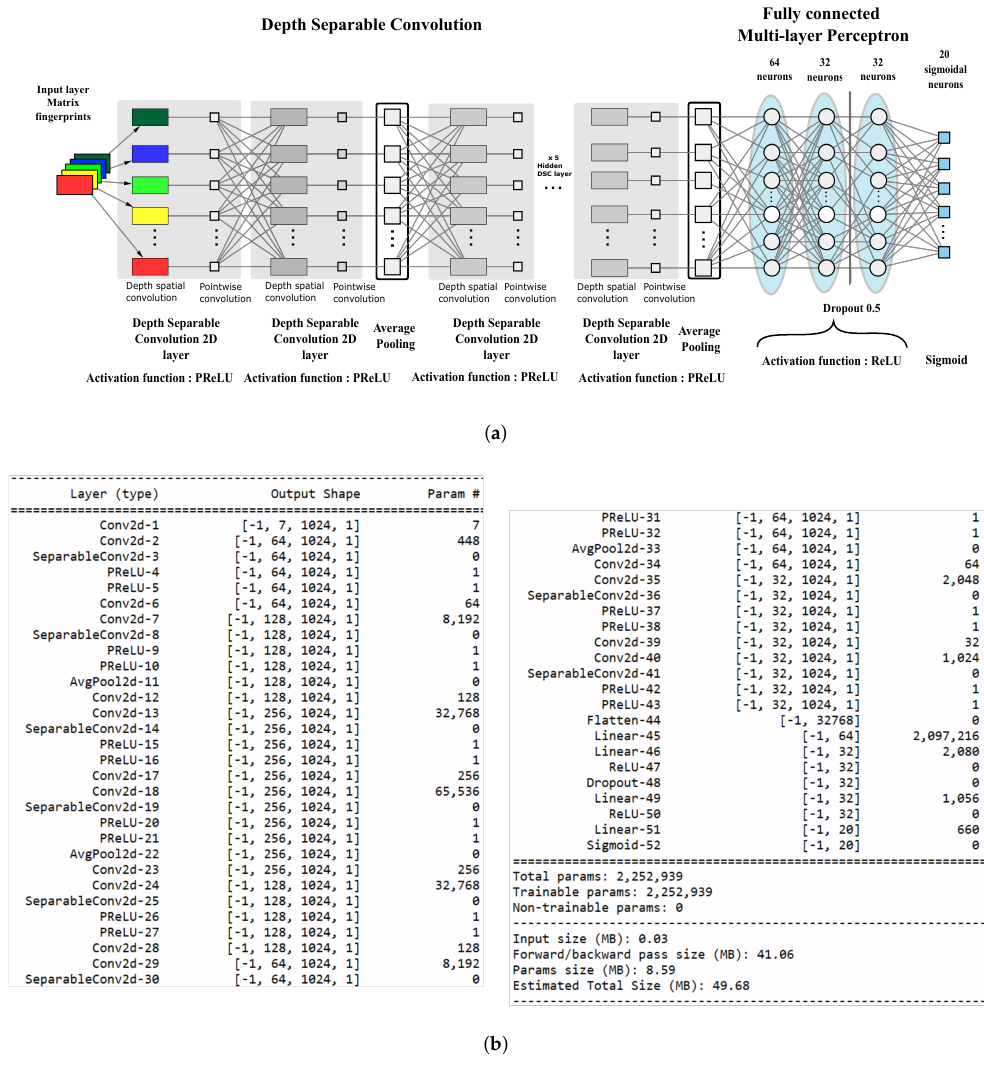
Figure 2. The proposed architecture. ( a ) Network layout. ( b ) Model